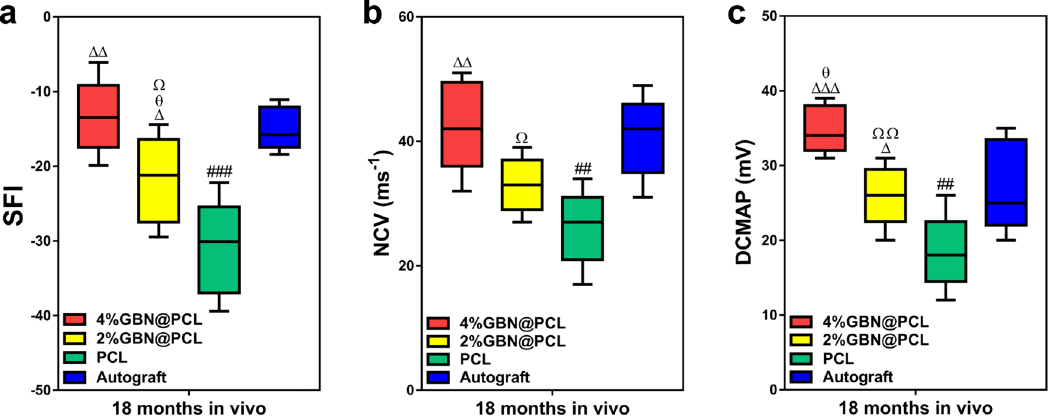
Fig. 5 Locomotor and electrophysiology performances of the peripheral nerves by GBN. SFI ( a ). NCV (ms − 1 ) ( b ). DCMAP (mV) ( c ). Δ represents p < 0.05, ΔΔ represents p < 0.01, ΔΔΔ represents p < 0.001 in comparison with PCL; ## represents p < 0.01, ### represents p < 0.001 for PCL vs. autograft. θ represents p < 0.05 in comparison with autograft. Ω represents p < 0.05, ΩΩ represents p < 0.01 for 4%GBN@PCL vs. 2% GBN@PCL. The center line, bounds of box, and whiskers were displayed in the fi gures,